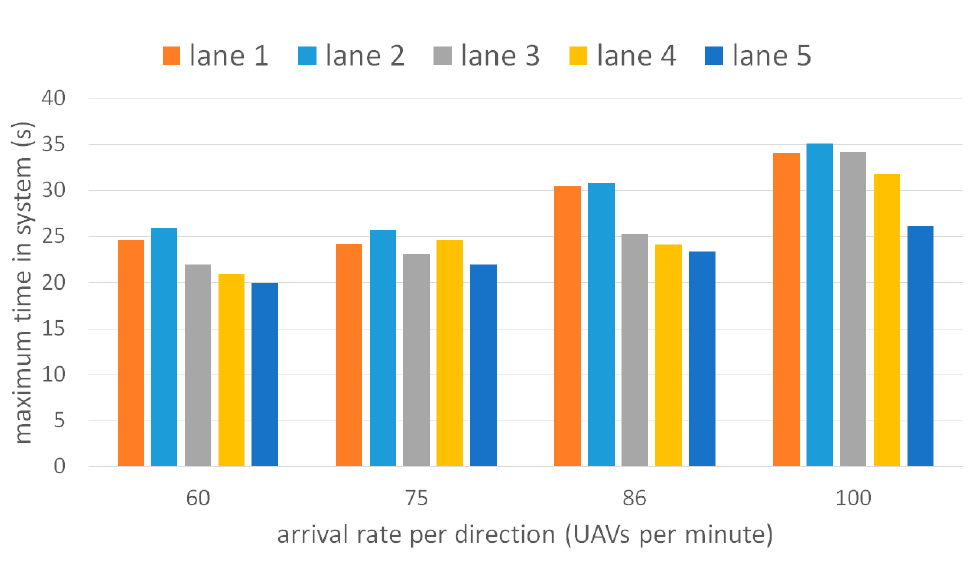
Figure 21. Maximum time in system of UAVs per lane using mode 2 and G = 80.